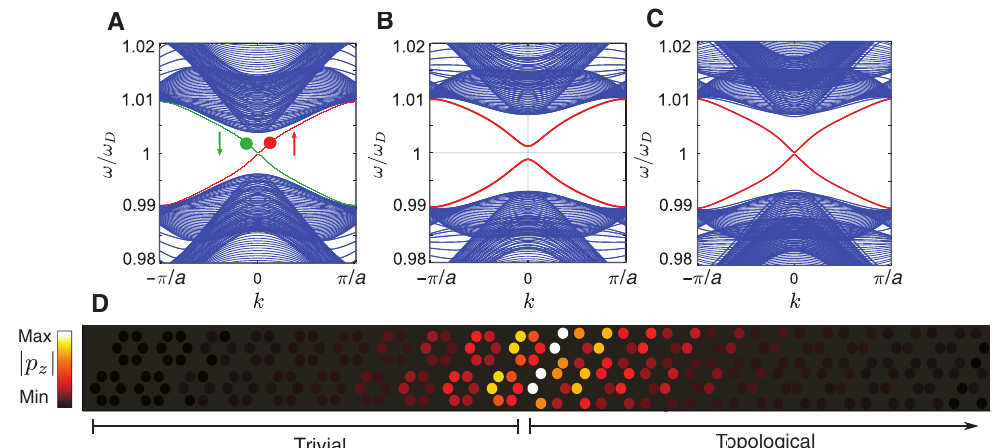
Figure 6: Edge states at the interface of trivial/topological lattices. Band structure of a strip of 40 unit cells with (A) t = 1.3 (topological), covered on both sides with 20 hexagons with t = 0.7 (trivial). The gap is closed by the unidirectional edge states (red bands). (B) Band structure when t = 1.6 and t = 0.4 in the topological and trivial regions, respectively. The edge states become gapped around Γ . (C) Band structure of the lattice with the same parameters when transition from t = 1.6 to t = 0.4 occurs adiabatically along six unit cells. (D) Confinement of the edge states to the